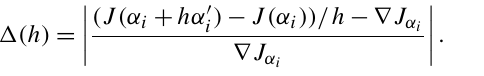
Fig. 6. Ratio ∆( h ) obtained with the Robin (black curves) and Control (red curves) inverse methods for perturbations of the enhancement factor to the viscosity E η ( x,y ) .